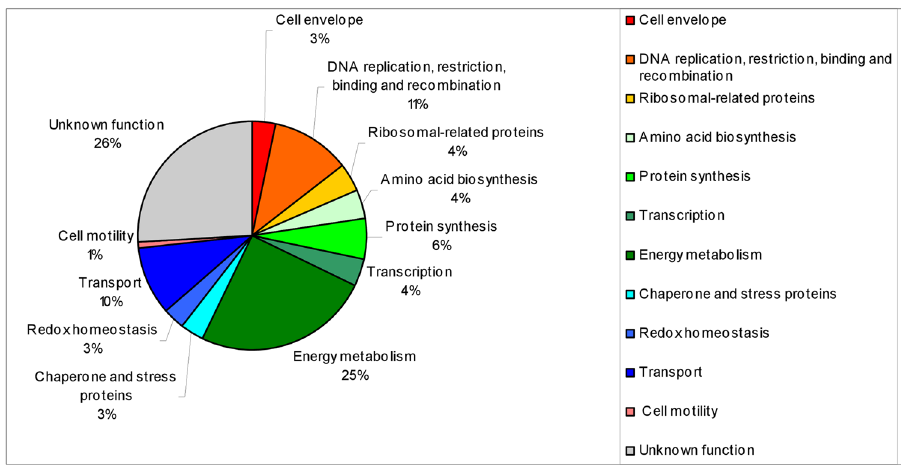
Figure 5. Functional classification of proteins identified in gels from